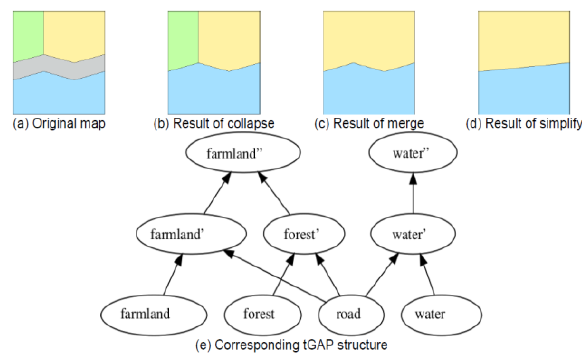
Figure 6. Vario-scale approach, topology connects hierarchical between LoD and good in storing attribute (Meijers, 2011).